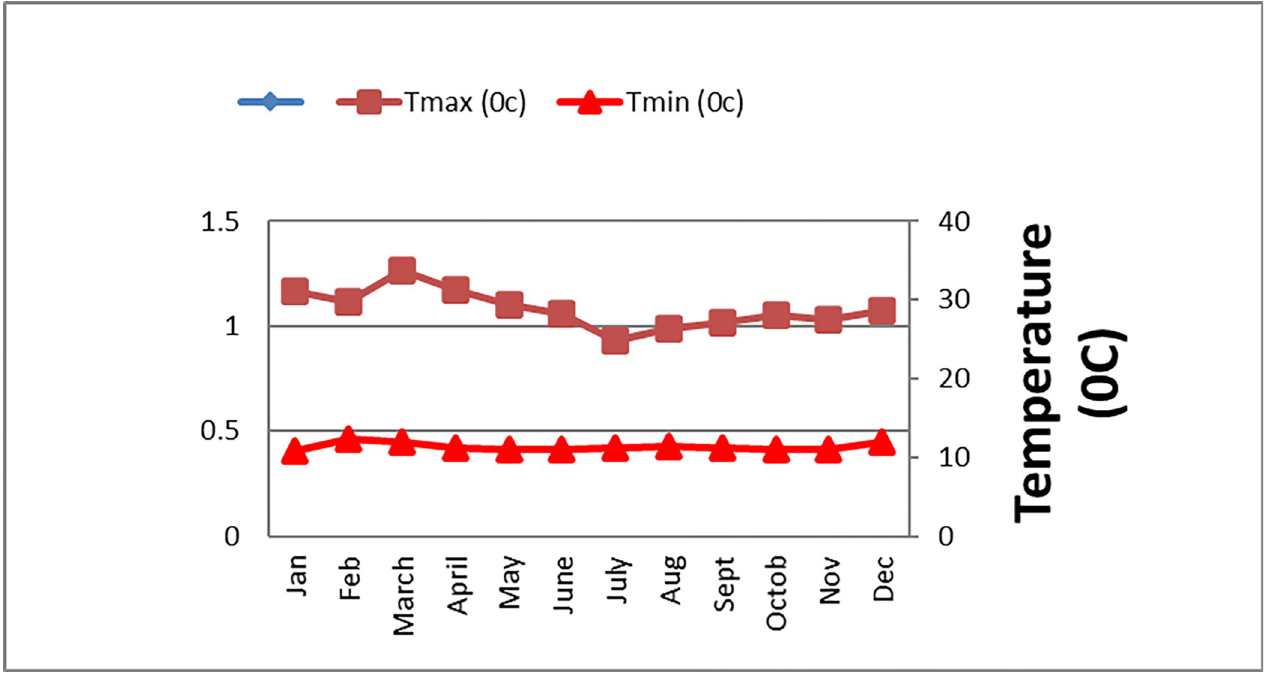
Fig 1. Mean minimum and maximum temperatures (˚C) of Mettu during crop growth period in 2017.